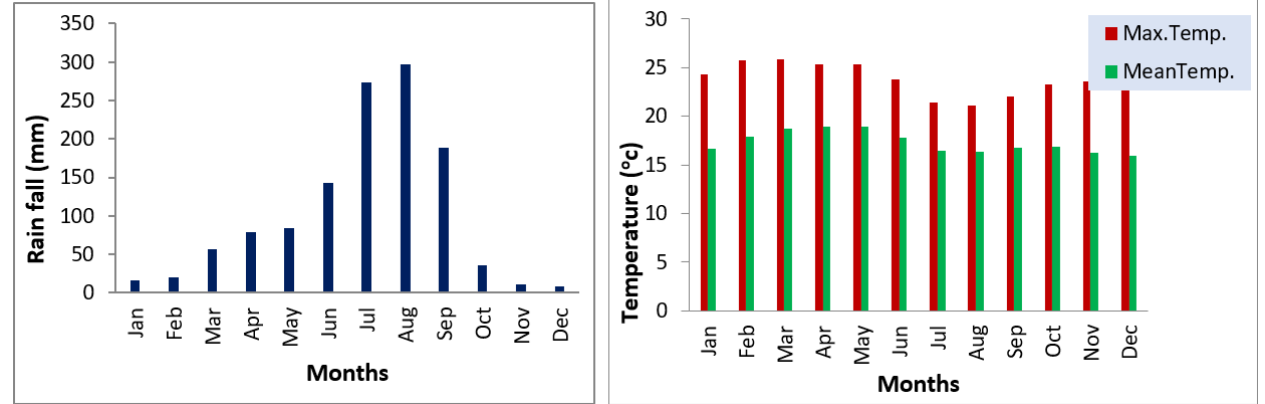
Figure 3. Long-term monthly rainfall ( left ) and temperature data ( right ) of the study area (Source: [20]).